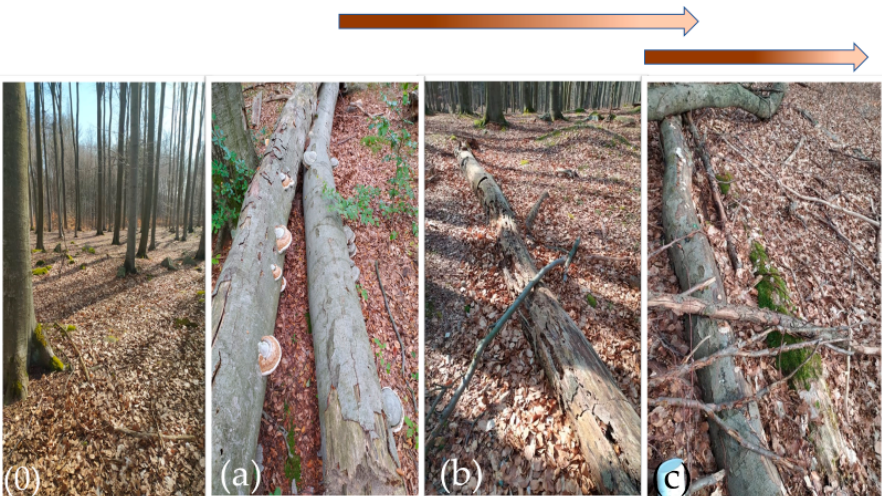
Figure 2. Development of the natural accumulation of deadwood in unmanaged stands within 70 years of abandonment in the University Forest Enterprise of the Czech University of Life Sciences Prague.